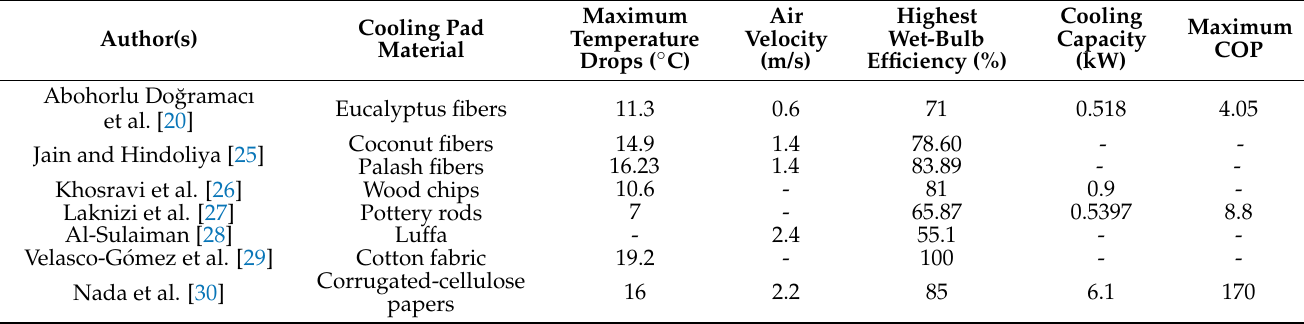
Table 1. Summary of some investigations on different cooling pad